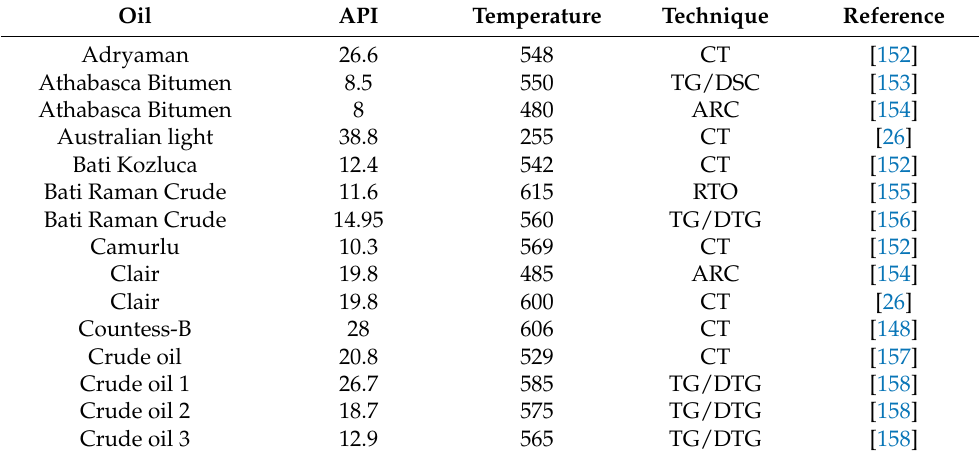
Table 2. Table of the reported experimental data of combustion properties of different oils from the literature with oil gravity, temperature reached and experimental method used. Thermo- gravimetry (TG), Differential Scanning Calorimetry (DSC), Accelerated Rate Calorimetry (ARC), and Combustion Tube (CT). API Temperature Technique